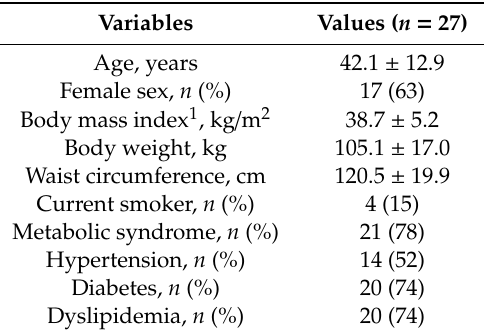
Table 1. Baseline